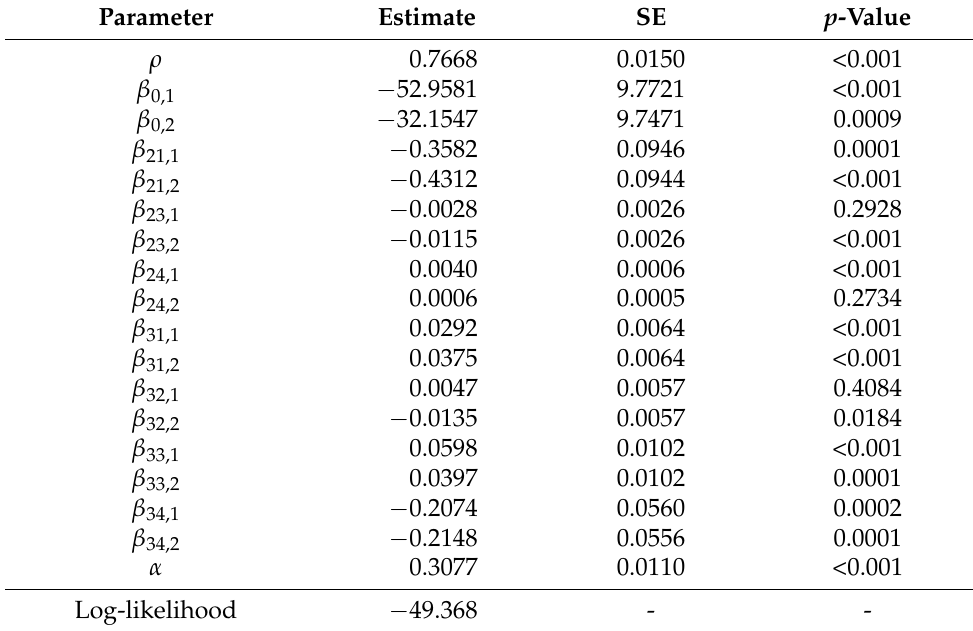
Table 3. ML estimate for listed parameter and corresponding estimated SE, p -value and maximized log-likelihood value for the BS model with Chilean PM